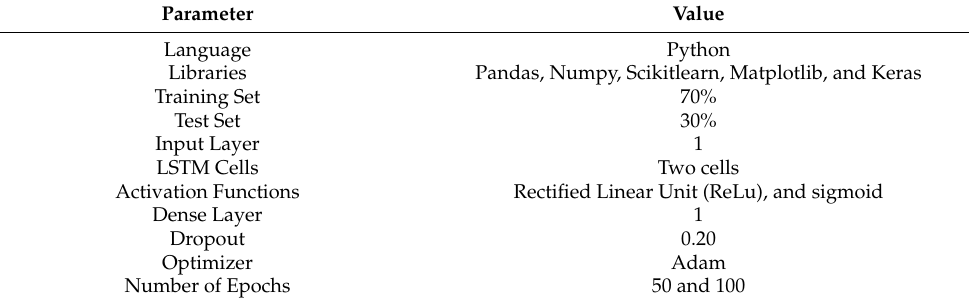
Table 6. Experimental results.